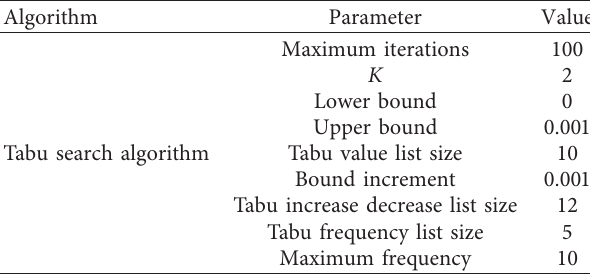
Table 3: Optimum tabu search algorithm parameters used in training artificial neural network models.